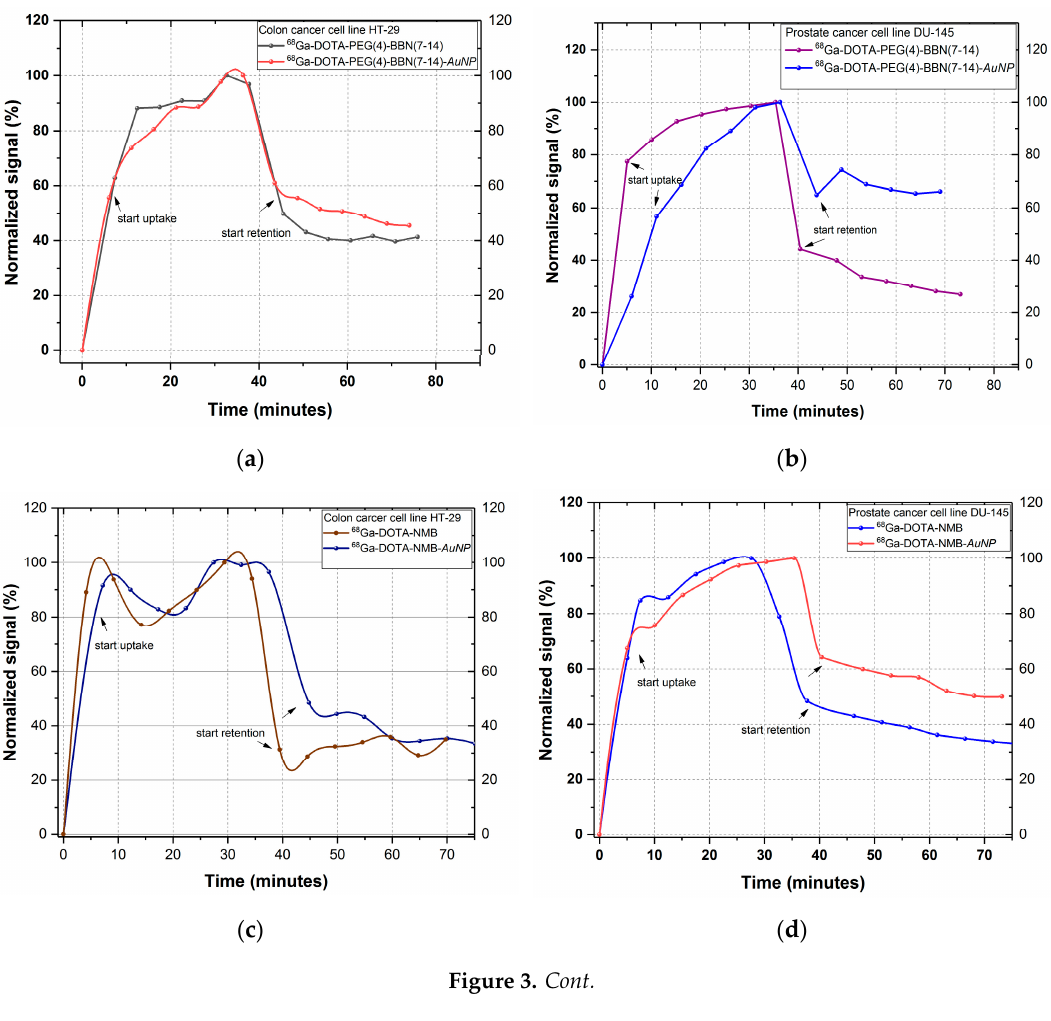
Figure 3. Figure 3. Cont.